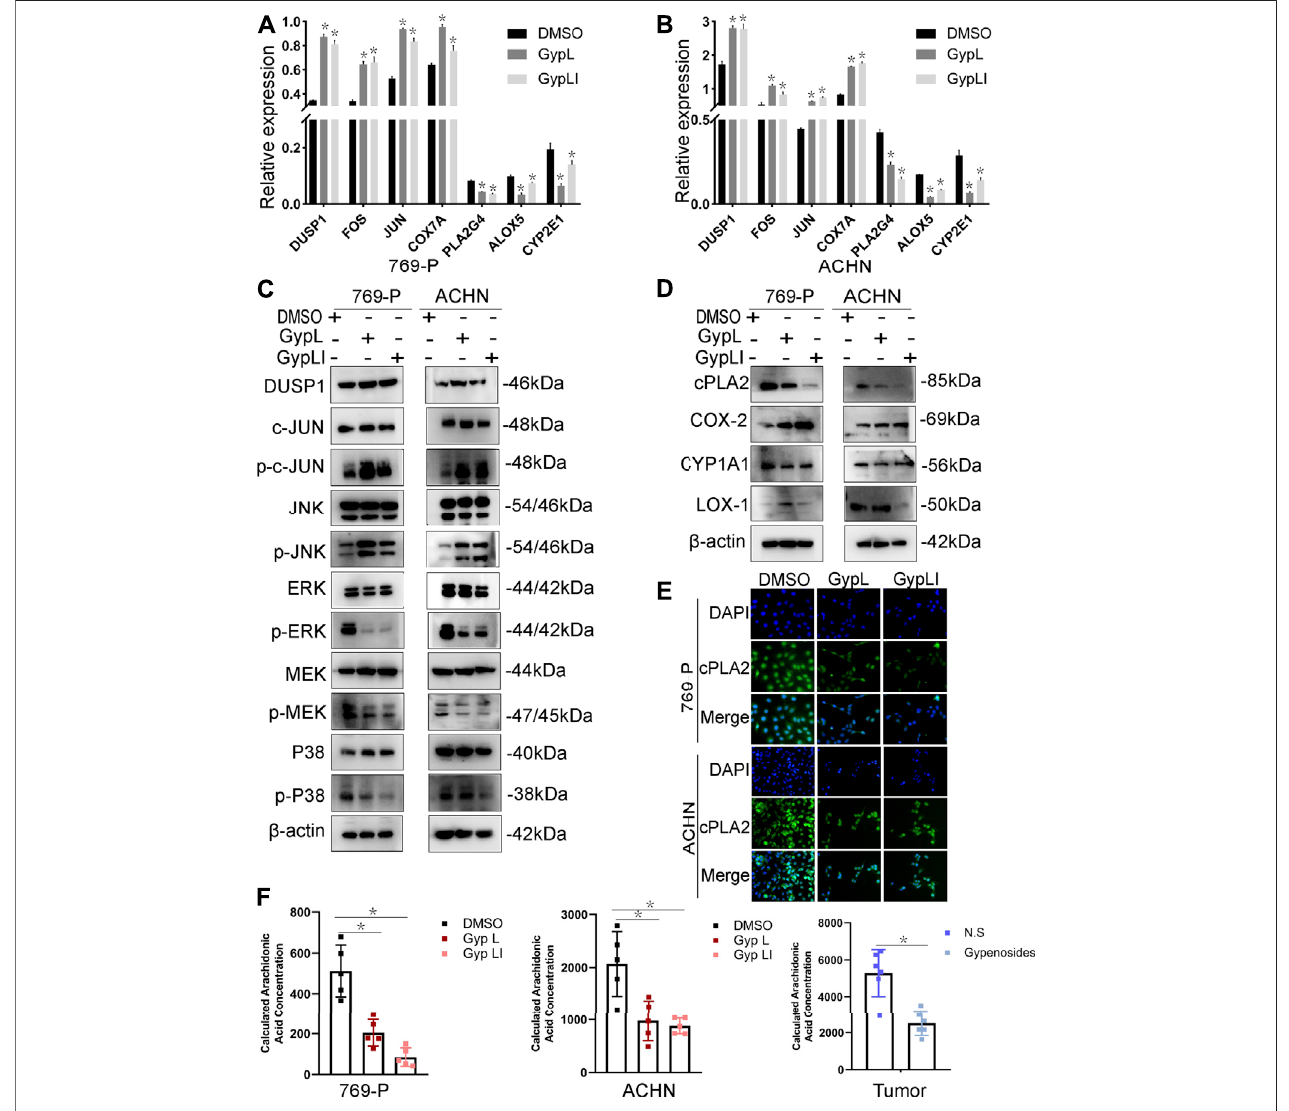
FIGURE4| ExpressionofMAPKandarachidonicacidmetabolismsignaling-relatedgenesandthereducedcontentofAAafterGypLandGypLItreatments. (A , B) The expressions of arachidonic acid metabolism signaling-related genes COX7A, PLA2G4, ALOX5, CYP2E1 and MAPK pathway-related genes DUSP1, FOS, JUN in 769-P (A) and ACHN (B) cells were detected by RT-qPCR. (C) The expression of MAPK-related proteins after Gyp L and Gyp LI treatments were detected via Western blotting. (D) The expression of arachidonic acid metabolism signaling-related proteins after Gyp L and Gyp LI treatments were detected via Western blotting. (E) The expression ofcPLA2 after Gyp L and Gyp LI treatment was detected byimmuno fl uorescence assays. (F) The levels ofarachidonic acid in 769-P and ACHN treated with Gyp L and Gyp LI and in tumor tissues after gypenoside treatment were measured by liquid chromatography-mass spectrometry (LC/MS). Data are presented as the mean ± SD of expression levels from three independent experiments (* p < 0.05, vs. control group).